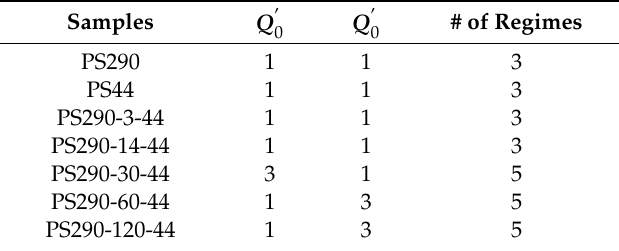
Table 2. The number of sign changes in Q (cid:48) to the plateau regime relating to the branches and the total number of resultant regimes.